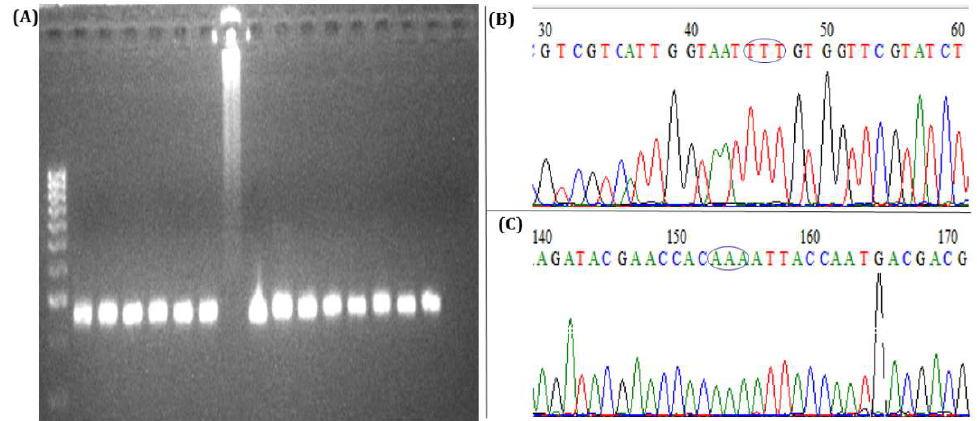
Figure 4. Genotyping of the IIS6 fragment of the voltage-gated sodium channel for the 1014 F kdr mutation in T. absoluta larvae. ( A ) Agarose gel of the nest 2 PCR fragment showing a characteristic band of around 270–280 bp; ( B ) and ( C ) are chromatogram traces respectively of forward and reverse sequences from a single T. absoluta larvae. The 1014 F codon is encircled in blue.